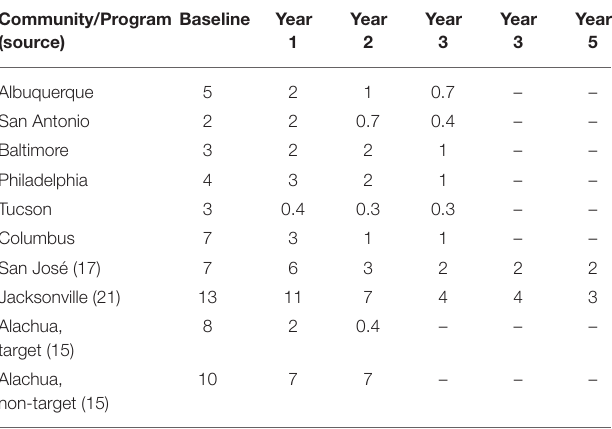
TABLE 8 | Annual reduction in feline euthanasia for each of six 3-year CCPs per 1,000 human residents in each corresponding shelter service area, and comparison to similar programs in other